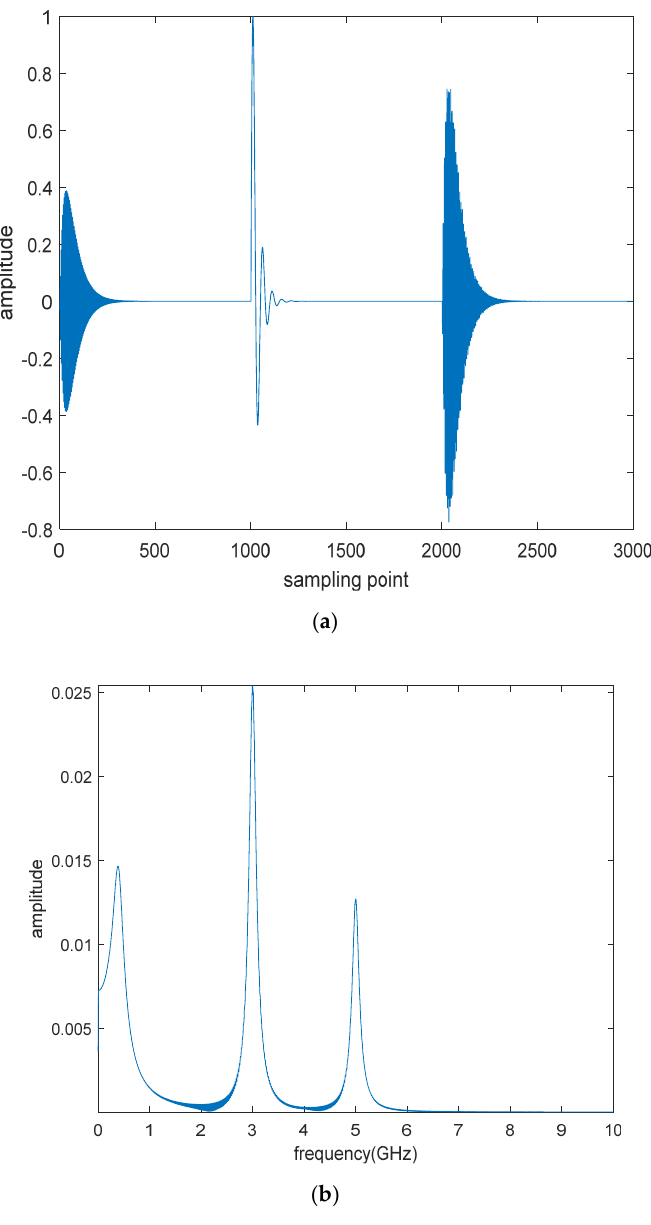
Figure 3. Pure PD signal. ( a ) In the time domain and ( b ) in the frequency domain. There are two cases to be discussed here, i.e., (1) PD signal contaminated by sinusoidal noise only and (2) PD signal contaminated by both sinusoidal noise and white noise.